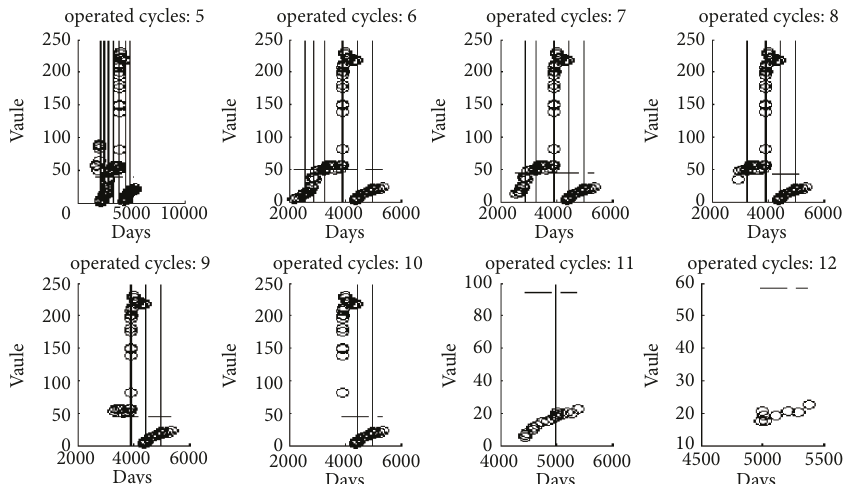
Figure 11: Actual value vs. predicted high value by PSO-SVM with different refueling cycle operation history for the main transformer taking TH as an example.